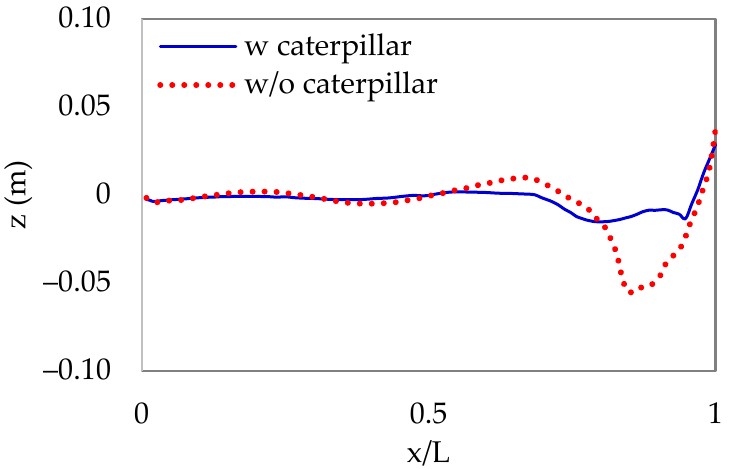
Figure 9. Wave profiles along the hull of vessels w/and w/o caterpillars at Fn = 0.27.